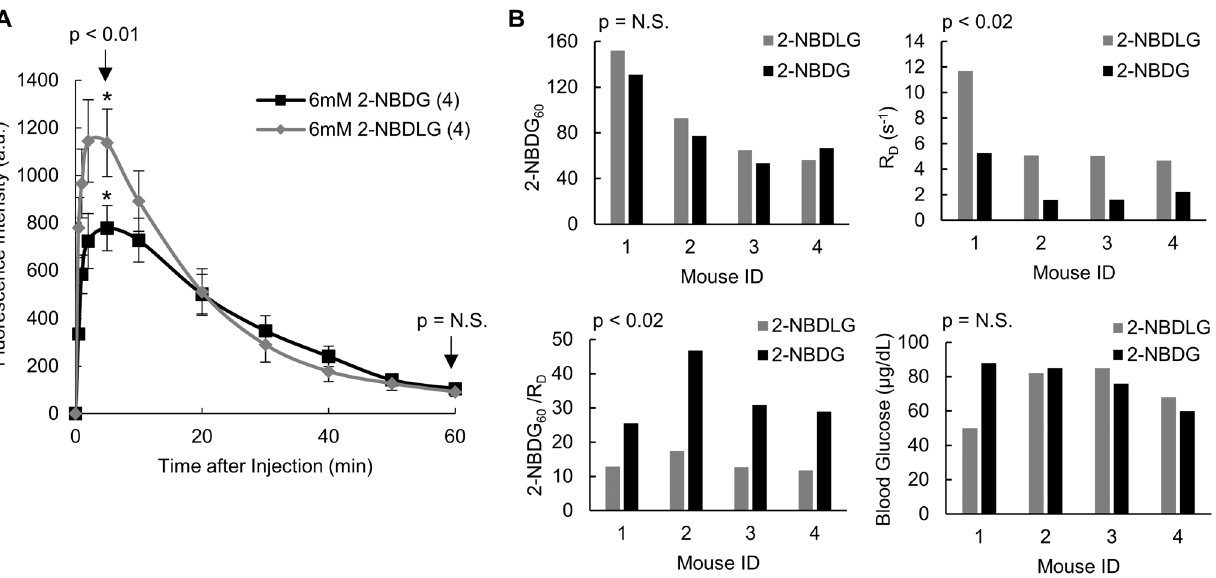
Fig. 4. The ratio 2-NBDG 60 /R D reflects stereo-specific uptake in vivo . (A) Mean kinetics of non-specific control (2-NBDLG) and specific tracer (2-NBDG) uptake imaged in the same cohort of mice on subsequent days. Peak fluorescence is significantly greater after 2-NBDLG administration than after 2-NBDG administration (p , 0.01). Fluorescence at 60 minutes is comparable for both tracers (p 5 N.S.) (B) Results of paired tracer and control imaging in a set of four mice. Neither blood glucose nor 2-NBDG 60 was significantly different between the two imaging perturbations (p 5 N.S.). R D was greater for the control 2- NBDLG than for 2-NBDG (p , 0.02). 2-NBDG 60 /R D identifies specific tracer uptake, as it is significantly greater for 2-NBDG than 2-NBDLG (p , 0.02). n 5 4 mice. Each p-value represents results of a student’s paired